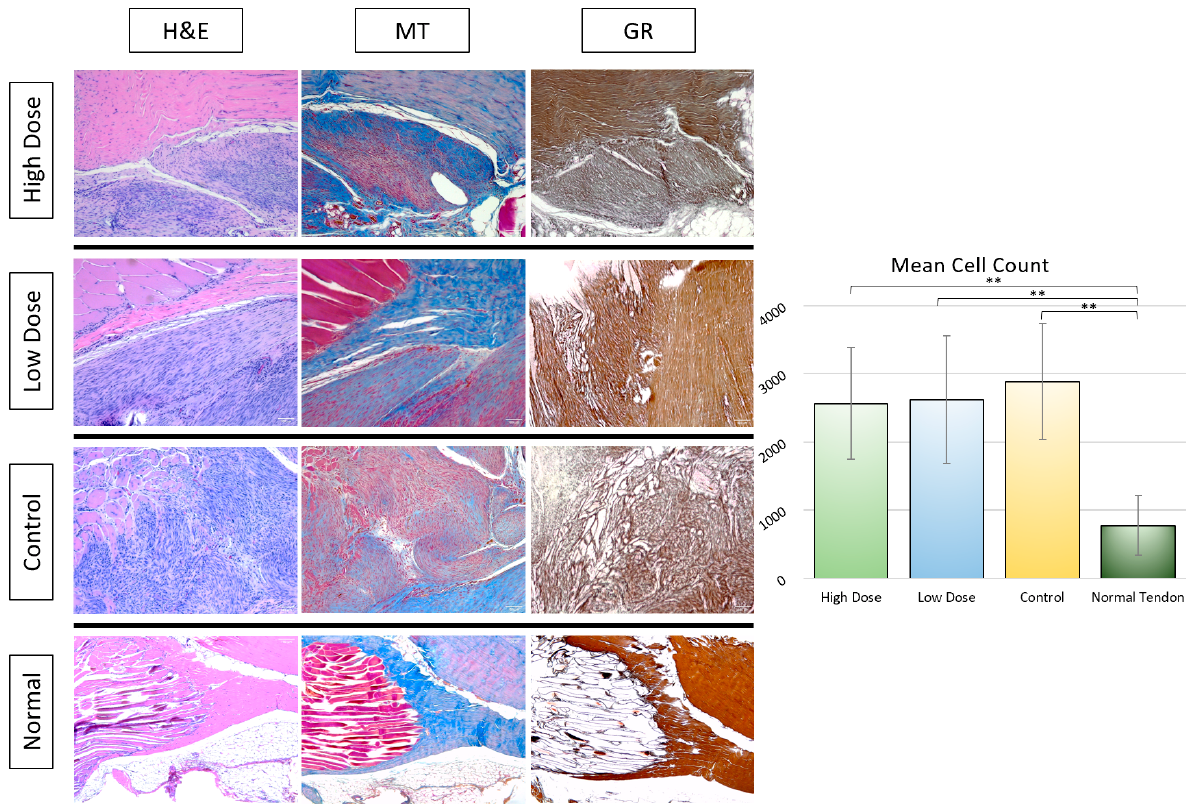
Figure 9. Histological staining of rat Achilles tendon 30 days after tendon injury and treatment compared to uninjured rat Achilles tendon. H&E staining highlights cellular density, architectural changes to the tendon matrix, cellular morphology, and abnormal vascularization or fat deposition within the tissue. Masson’s Trichrome staining highlights changes in the tendon extracellular matrix with more normal tendon tissue (blue) and muscle (bright red) differentiated from the abnormal matrix (dull red). Gomori’s Reticulin stain highlights abnormal reticular fiber conformation and overall organization of fibrous tissue within the tendon. Scale bar = 100 μ m. Mean cell counts on H&E-stained samples are depicted to the right. “**” represents p < 0.01 in pairwise comparison.